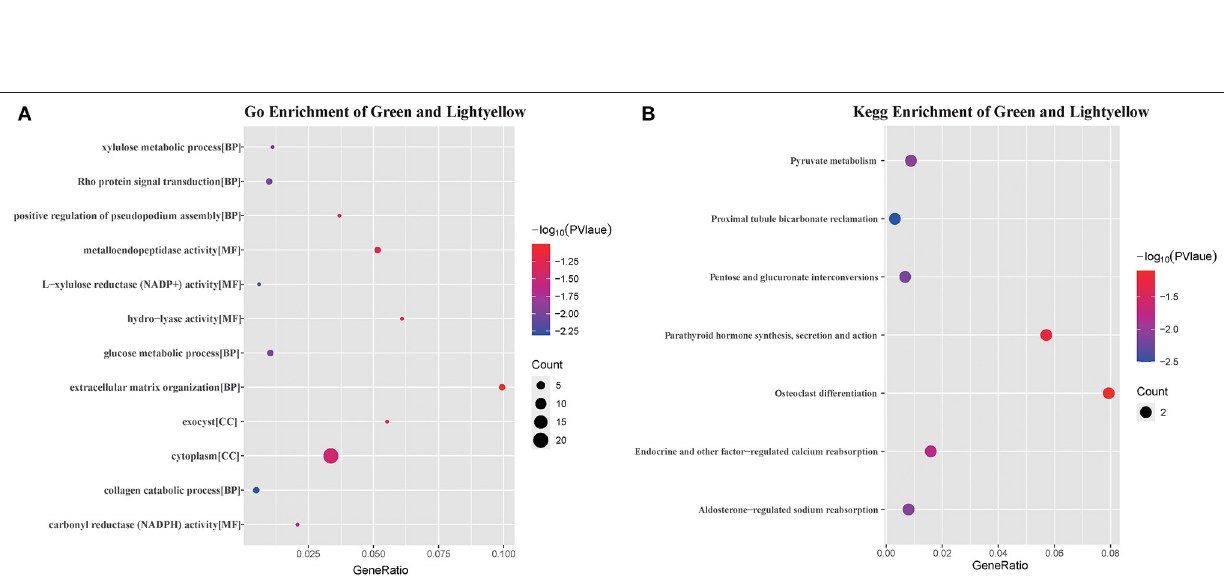
FIGURE 6 | Correlation analysis of all modules with SARA samples and Non-SARA samples, positive correlations in red and negative correlations in green, values in parentheses are p -values, correlations were considered significant when p -values were < 0.05.